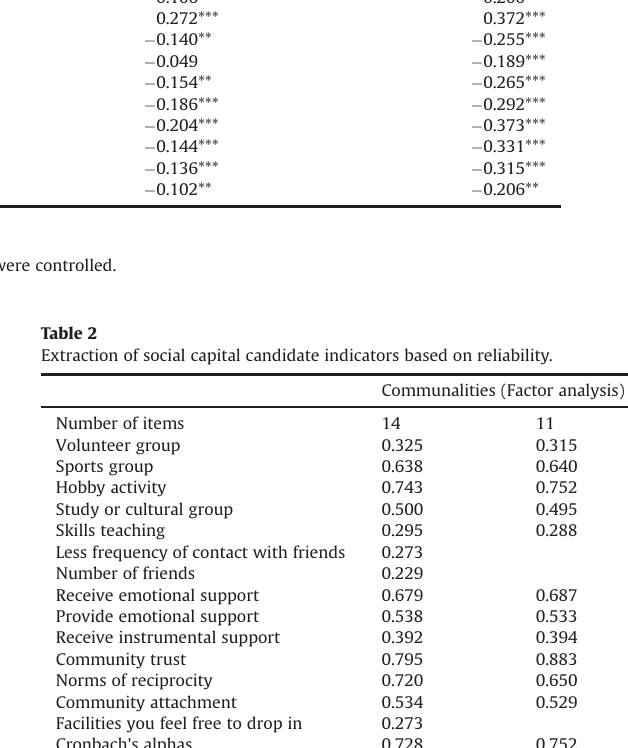
Partial correlation a